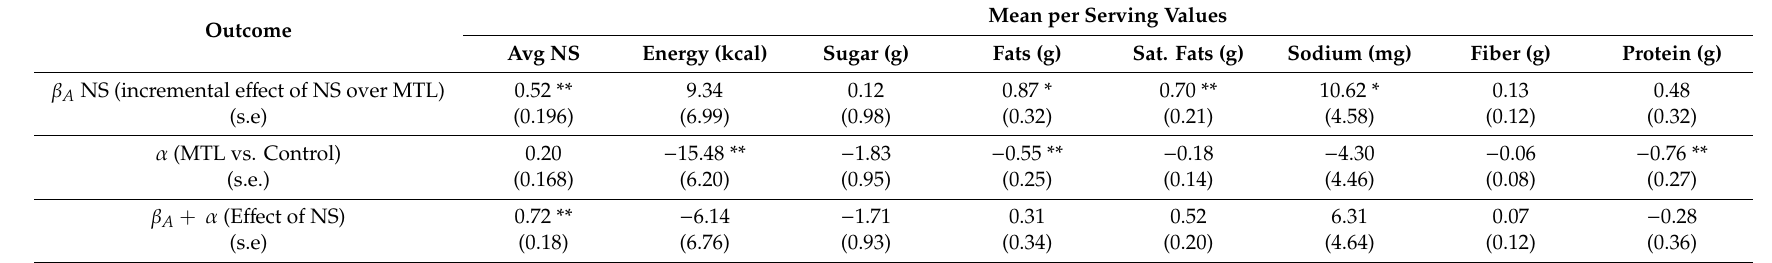
Table A5. Regression for beverages only with dietary quality and per serving values outcomes ( N = 190, n = 111). Outcome